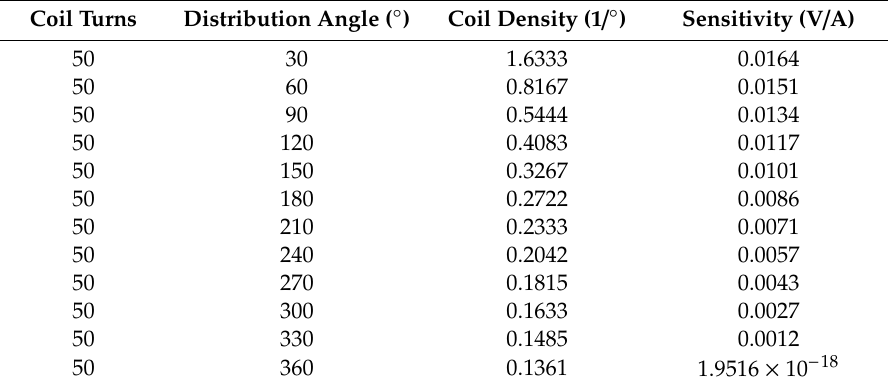
Table 2. Sensitivities corresponding to di ff erent distribution angles.